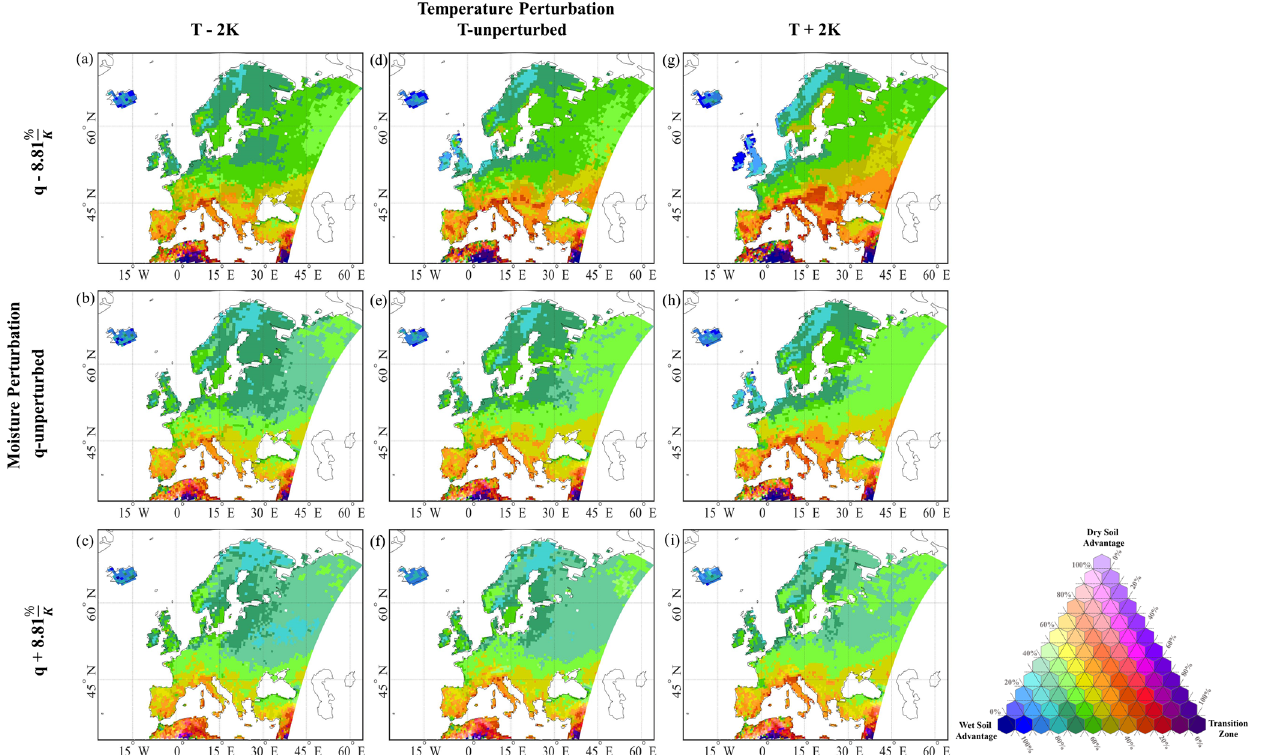
Figure 6. Composition of the non-atmospherically controlled days comprising wet soil advantage, dry soil advantage and transition zone days for all core modification cases. The columns denote the temperature change and the rows the relative change in